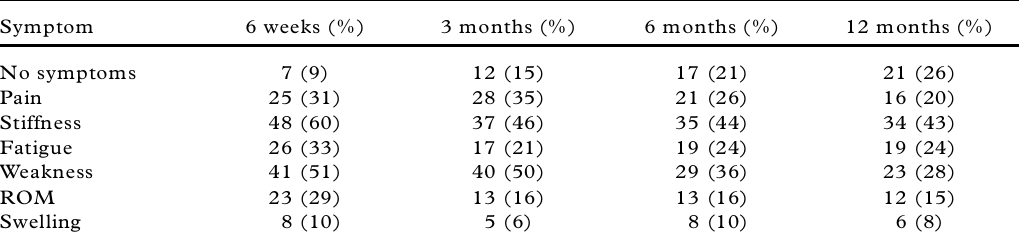
Table 1. Frequency of symptoms in 80 subjects with lower extremity tumours treated by limb preservation